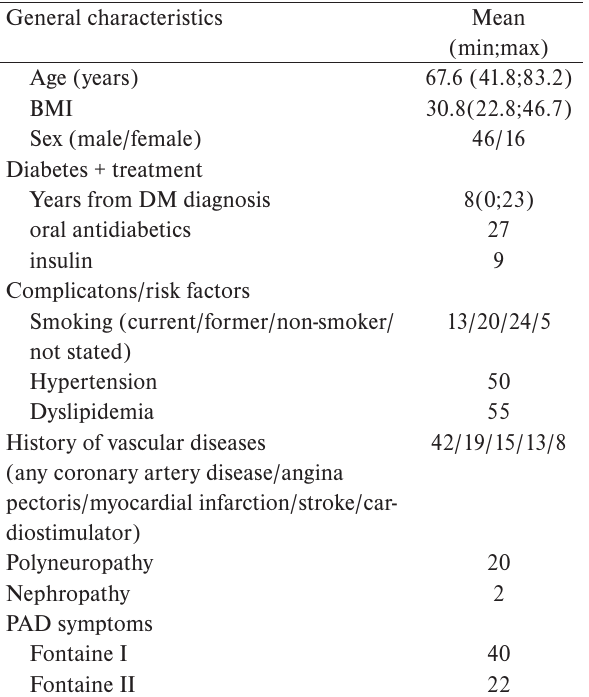
Table 1. Characteristics and risk factors for the study